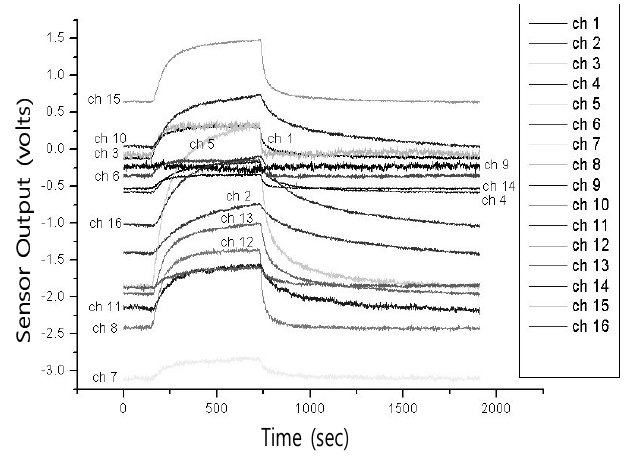
Figure 1. Typical time-responses of 16 channel sensor array with respect to inflow of acetone vapor at 5,000 ppm